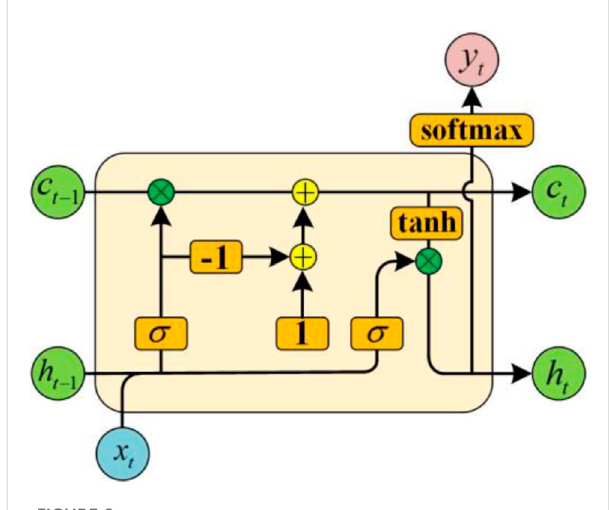
FIGURE 2 Basic unit structure diagram of CIF-LSTM network.